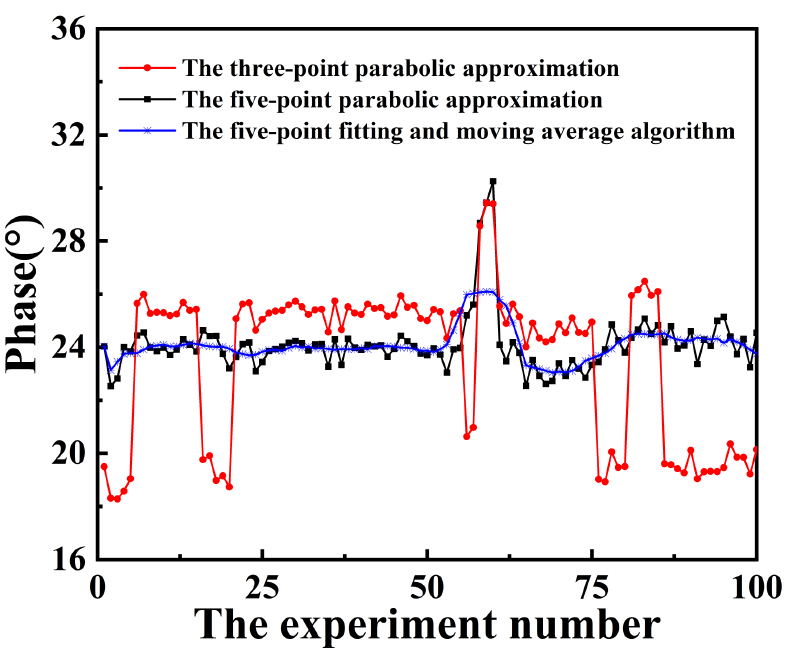
Figure 5. The phase characteristics processed by three